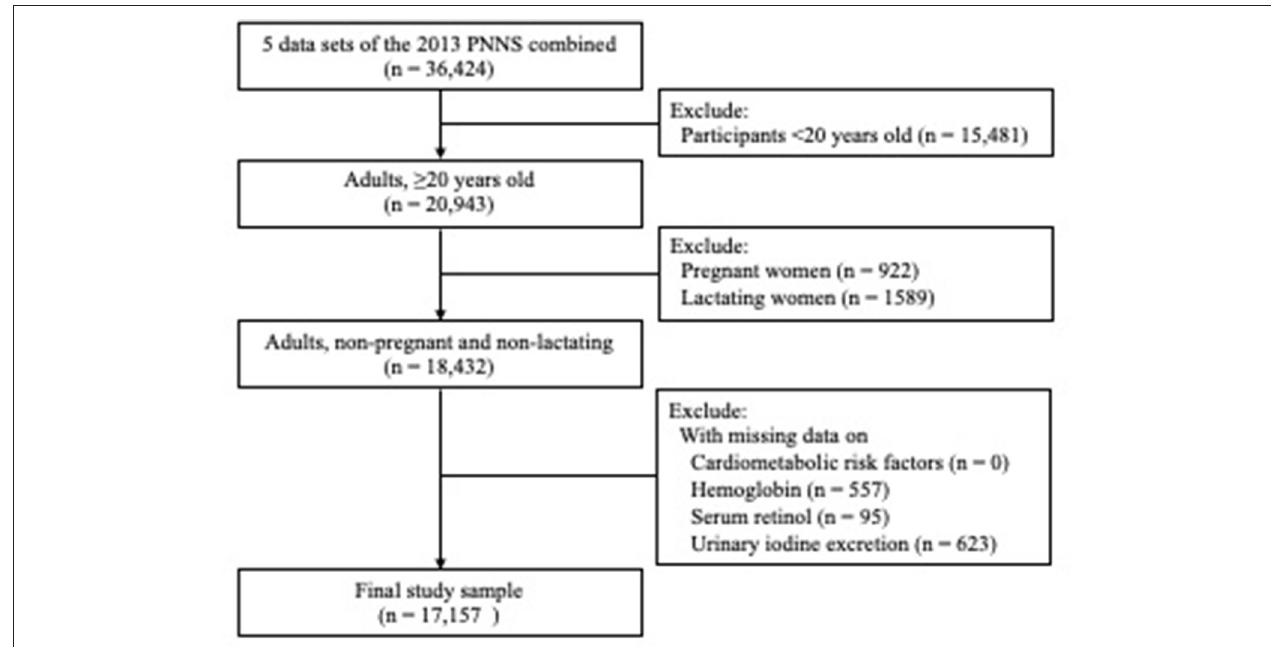
FIGURE 1 | Flow diagram of participants excluded in the study. Cardiometabolic risk factor was defined as an individual with any of the following four factors: (1) overweight/obesity or abdominal obesity; (2) hypertension; (3) hyperglycemia; (4) dyslipidemia (low HDL cholesterol or hypertriacylglycerolemia). There were no study participant with missing value on cardiometabolic risk